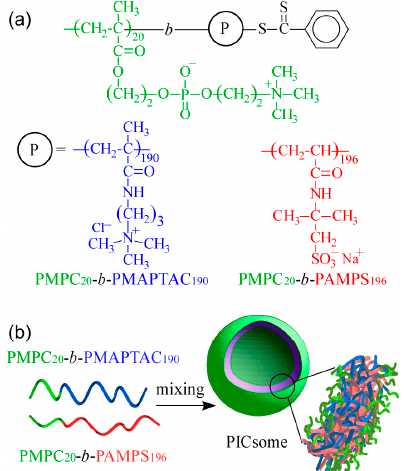
Figure 1. ( a ) Chemical structures of oppositely charged diblock copolymers, poly(2-(methacryloyloxy)ethyl phosphorylcholine)- block -poly((3-(methacrylamido)propyl) trimethylammonium chloride) (PMPC 20 - b -PMAPTAC 190 , P 20 M 190 ) and poly(2-(methacryloyloxy) ethyl phosphorylcholine)- block -poly(sodium 2-(acrylamido)-2-methylpropanesulfonate) (PMPC 20 - b -PAMPS 196 , P 20 A 196 ); ( b ) conceptual illustration of a polyion complex vesicle (PICsome) composed of a stoichiometric charge-neutral mixture of P 20 M 190 and P 20 A 196 .